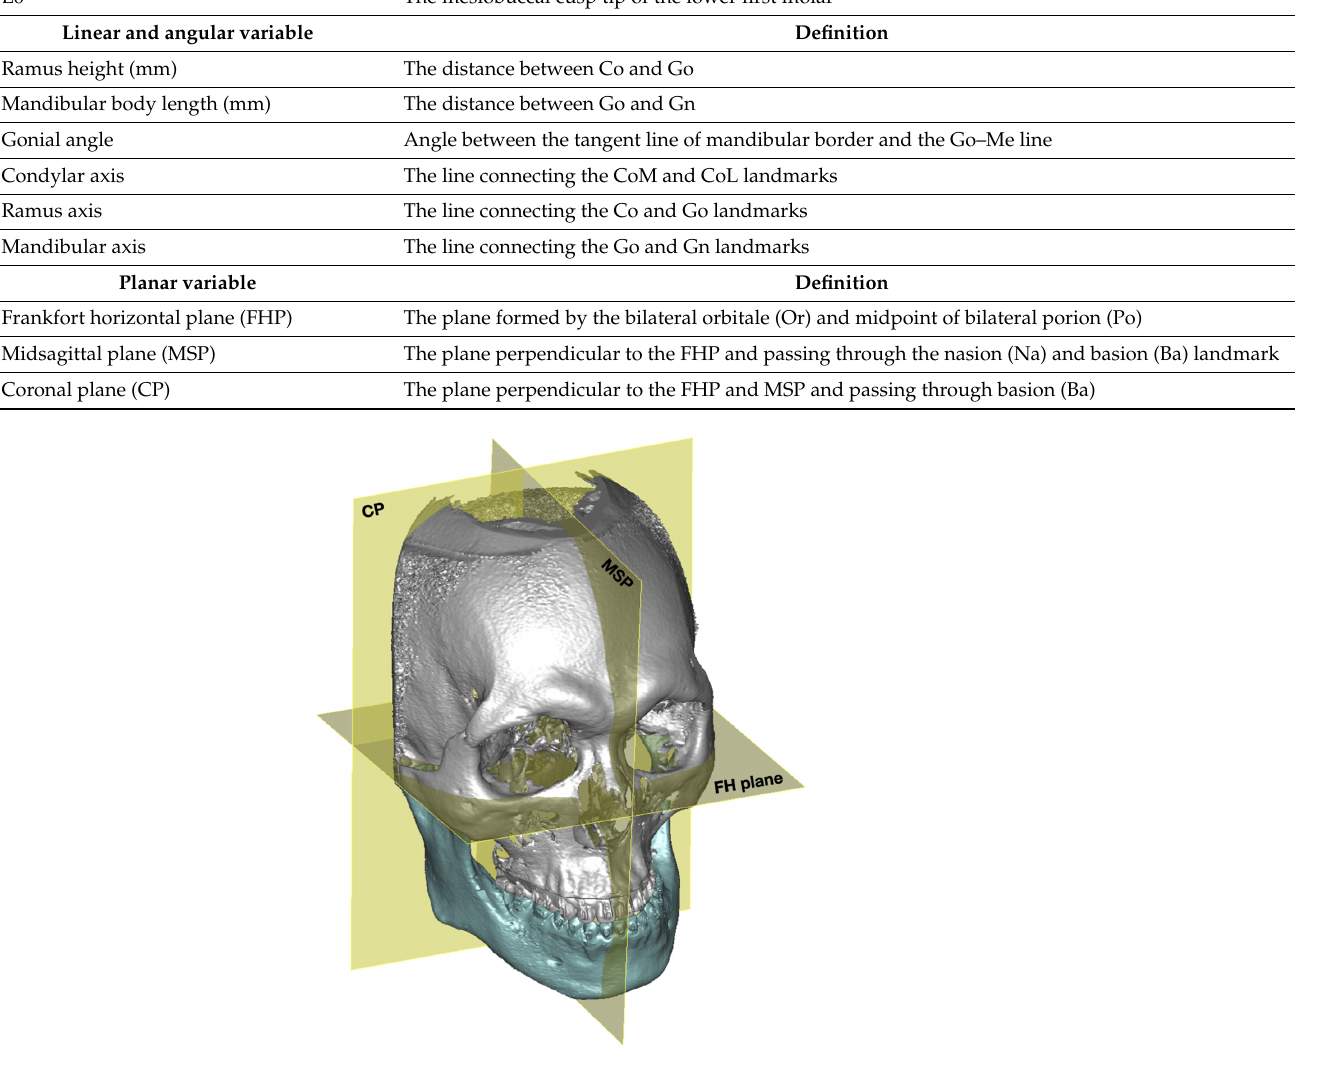
Figure 1. Three reference planes for 3D analysis. The 3D reference planes were constructed by the landmarks identified on the preoperative objects. The Frankfort horizontal plane (FHP) was determined by the bilateral orbitale and the midpoint of the bilateral porion. The midsagi tt al plane (MSP) was de fi ned as the plane perpendicular to the FHP and passing through the nasion. The coronal plane (CP) was the plane perpendicular to the FHP and the MSP, and passing through the basion.